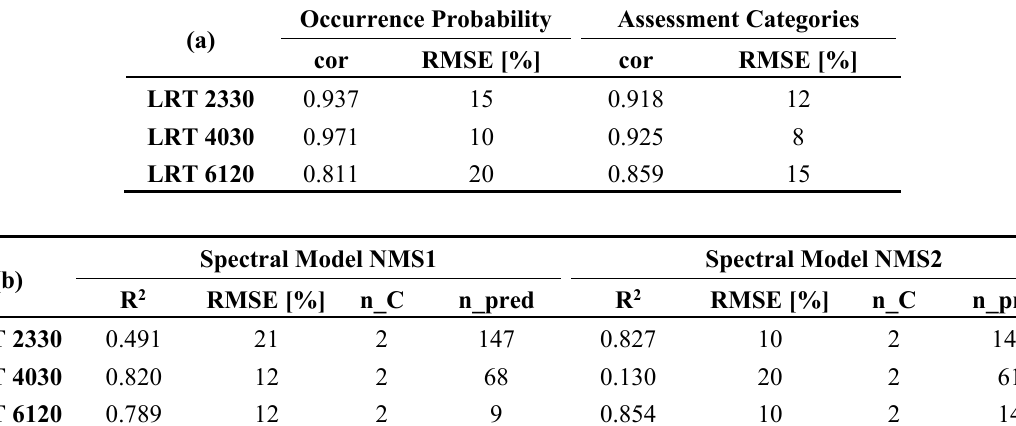
Table 4. ( a ) External validation between kriging grids on the ordination plane for terrestrial mapping and habitat functions. ( b ) Internal LOO validation between spectral variables and axis scores. cor = Pearson product-moment correlation; RMSE = root mean squared error; R 2 = coefficient of determination; n_C = number of latent components in final PLSR-model; n_pred = number of significant predictors/spectral variables. Occurrence (a)